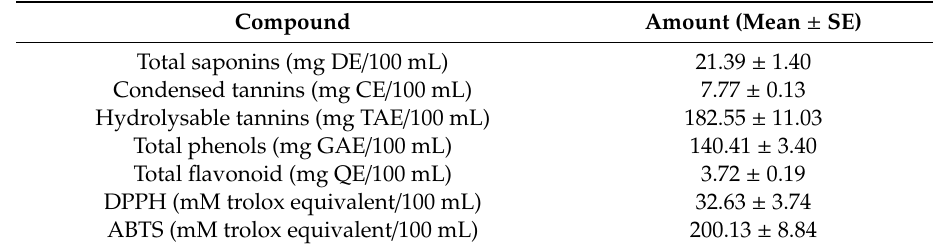
Data are represented as mean ± SE of three measurements. DE: Diosgenin equivalent; CE: cathechin equivalent; TAE: tannic acid equivalent; GAE: gallic acid equivalent; QE: quercetin